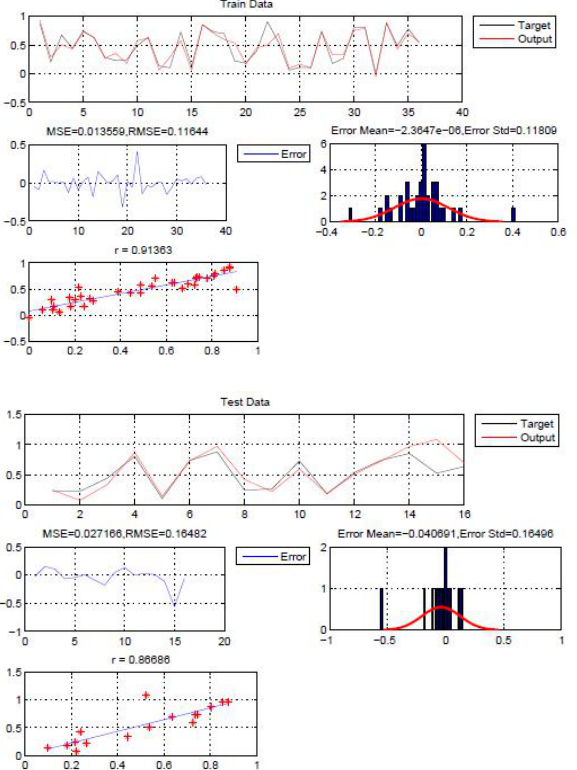
Figure 4. Top : The training results of PSO-ANFIS. Bottom : The test results of